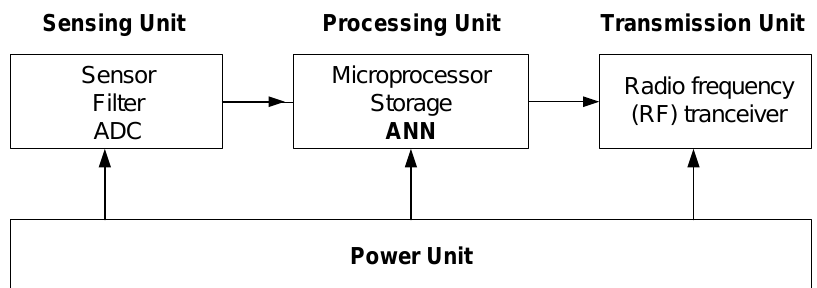
Figure 1. The structure of an intelligent sensor equiped with artificial neural